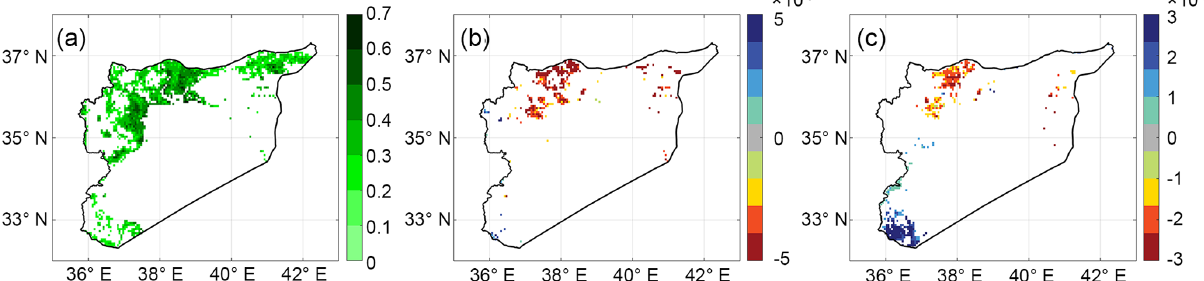
Figure 6. (a) Correlations between the N–A precipitation and the EVI in the growing period; (b) trends of EVI residuals after removing the linear fitting by precipitation (10 − 3 yr − 1 ); (c) rainfall use